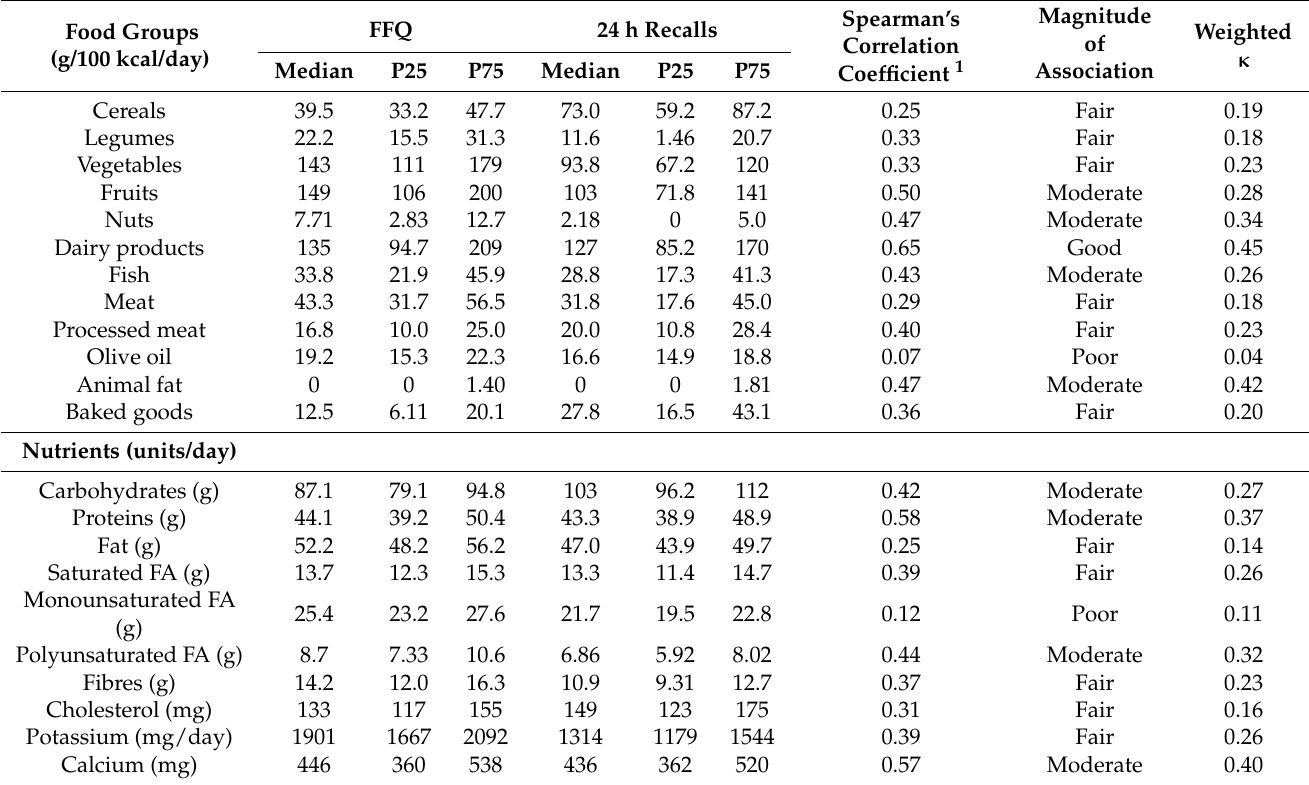
Table 4. Concurrent validity and concordance of foods and nutrients per 1000 kcal derived by the food frequency question- naire and 24 h recalls ( n =